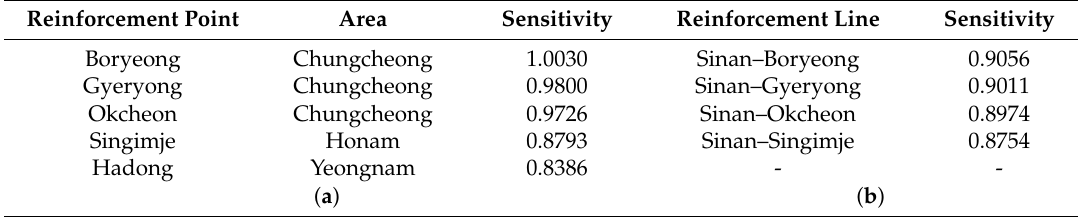
Table 15. ( a ) Reinforcement bus sensitivity analysis; ( b ) sensitivity analysis of the reinforcement line.